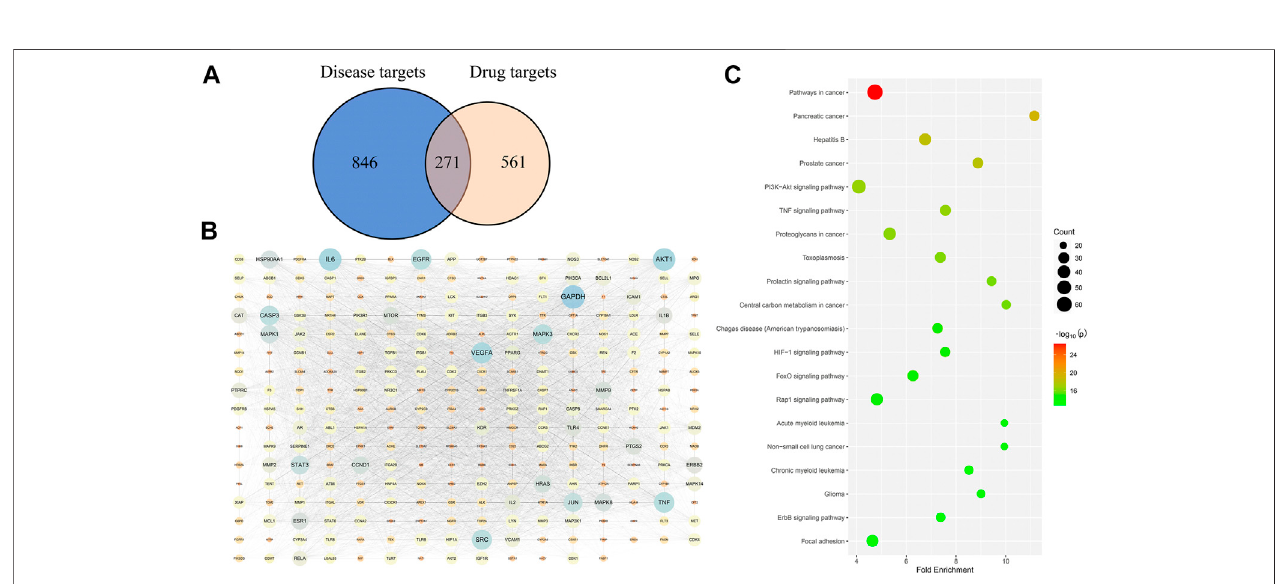
FIGURE5| Network pharmacology – basedanalysisofthetreatmentofDILI withHugan tablets. (A) CommontargetsofHugantablets and DILI. (B) PPInetworkof potential targets. (C) KEGG pathway enrichment results.